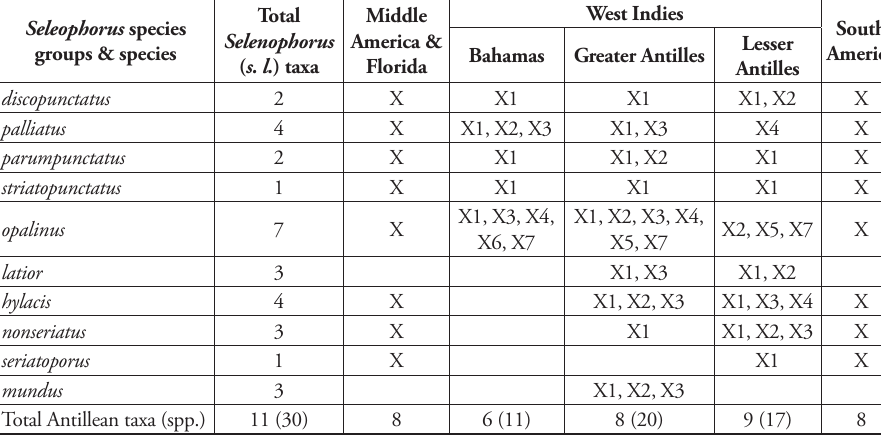
Table 8. Geographical distribution of the species groups and species of Selenophorus ( sensu lato ) in the West